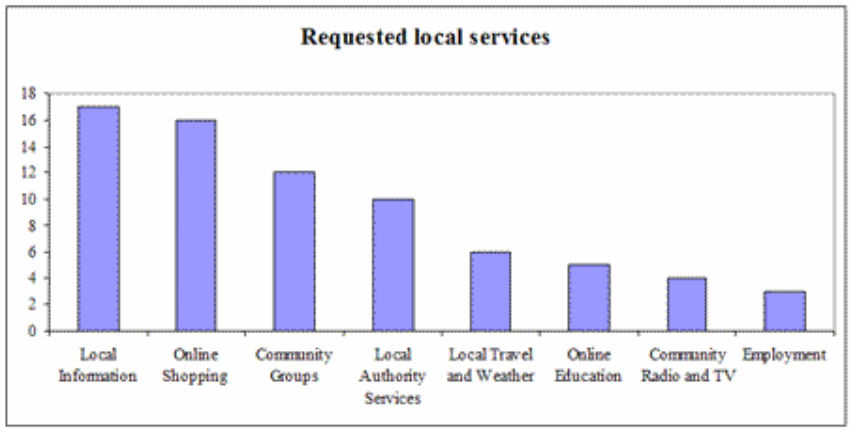
Figure 7. Respondents’ Requests for Desirable Online Local